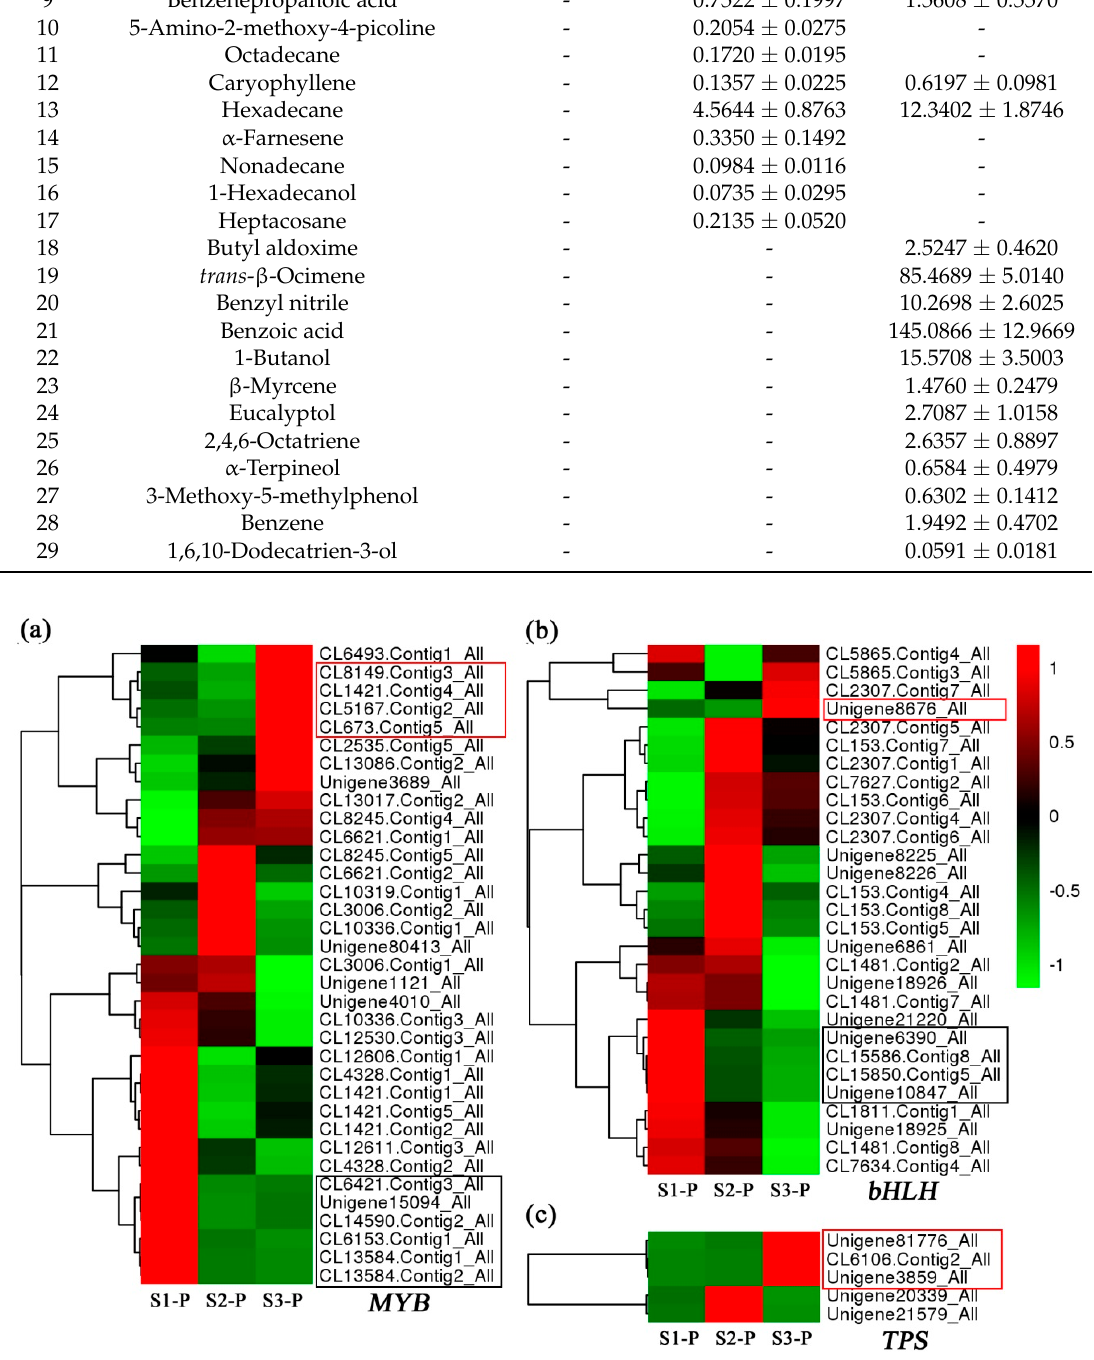
Figure 5. The expression profiles of differential expressed candidate genes. The heatmaps are generated according to the average expression levels of MYB ( a ), bHLH ( b ), and TPS ( c ) genes based on log2 transformed FPKM data. Green means low expression, and red means high expression.